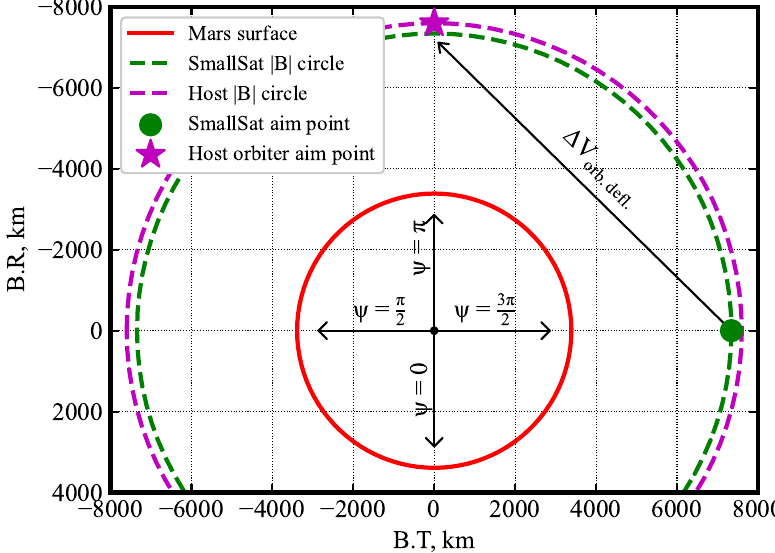
Figure 12. Small satellite and host orbiter aim points on the Mars B-plane. After releasing the SmallSat, the host orbiter performs a deflection maneuver to target its aim